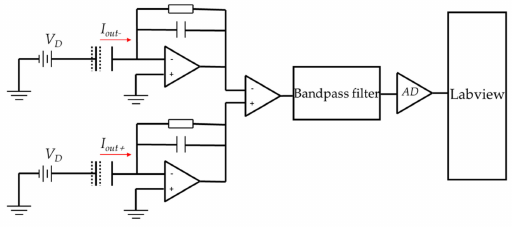
Figure 4. The schematic of the capacitive